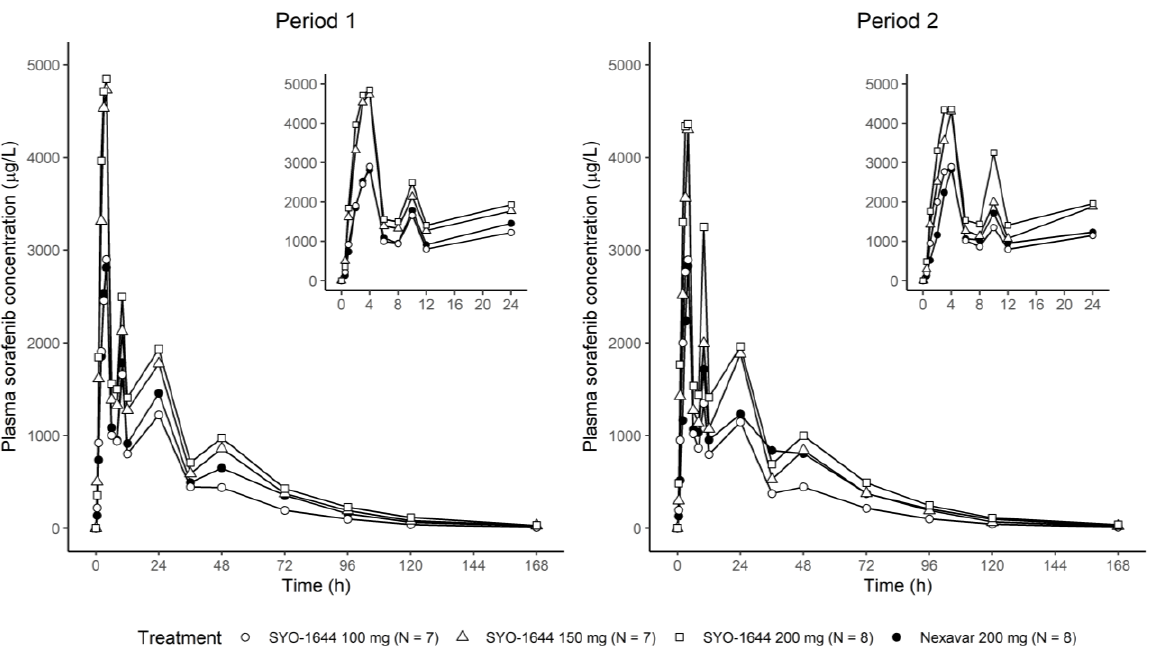
Figure 2. Mean plasma sorafenib concentration after single administration of SYO-1644 100, 150, 200 mg and Nexavar ® 200 mg (inset: time points until 24 h).